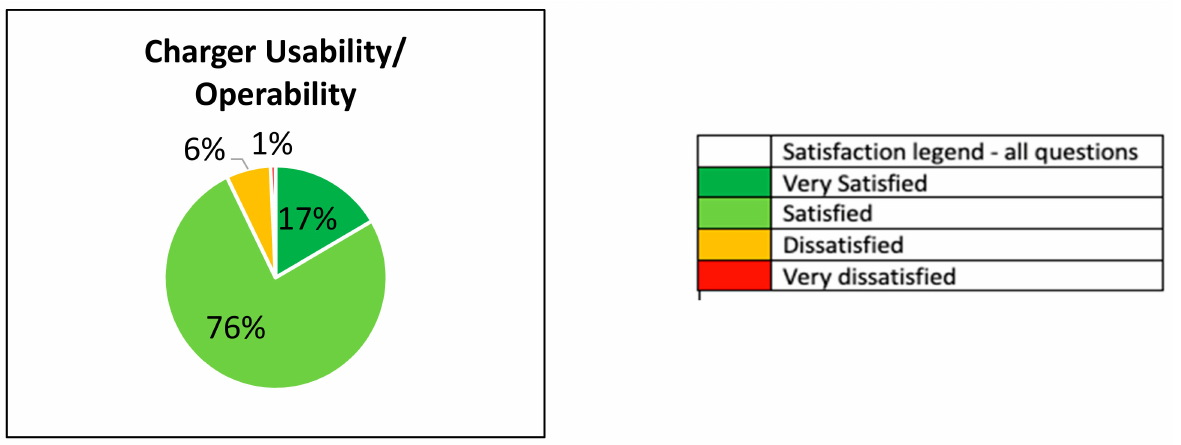
Figure 19. Rapid charge usability, availability and operability satisfaction—with Legend.